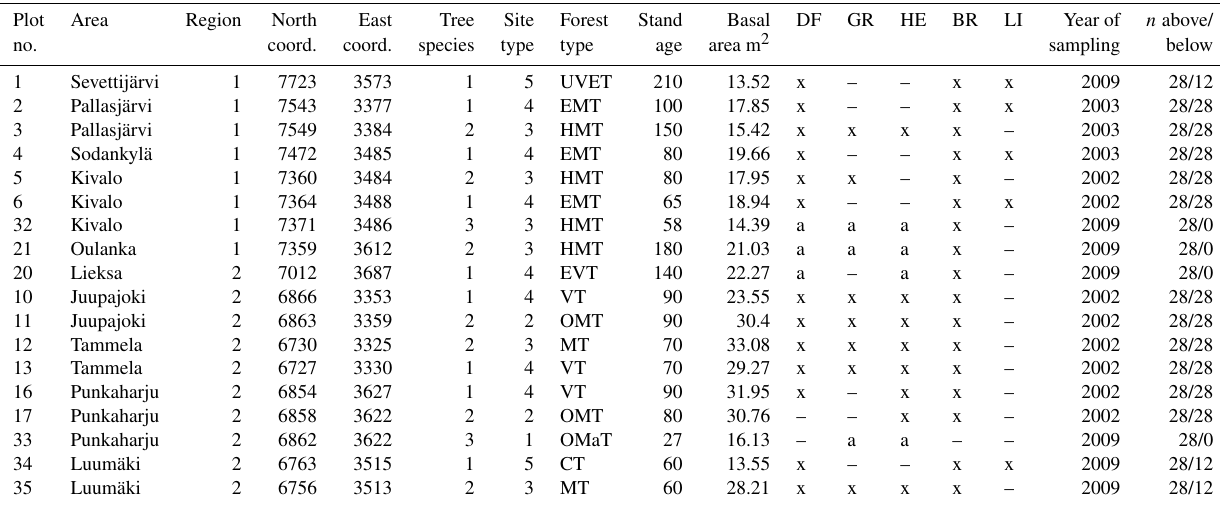
Table 1. Site description of ICP Forests Level II plots studied for understorey vegetation biomass. Plot Area Region n above/